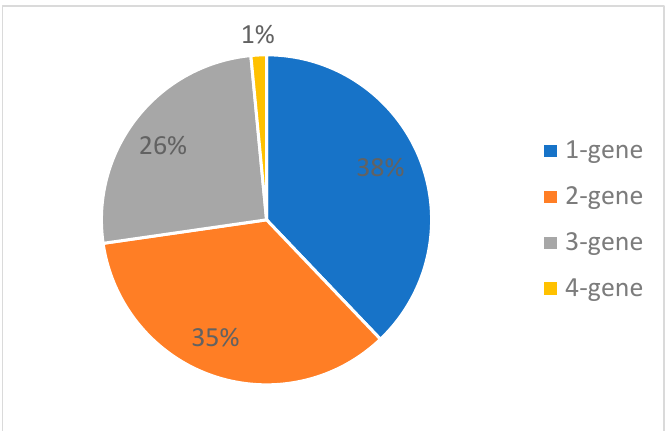
Figure 2. The number of genes detected by PCR tests for SARS-CoV-2 available in Poland.